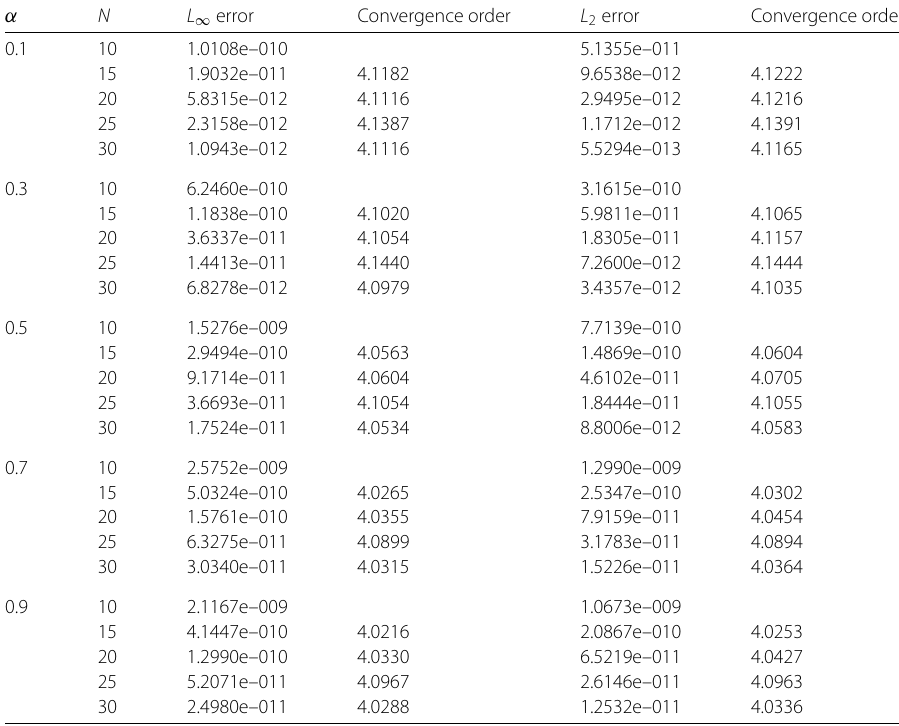
Table 6 The L ∞ , L 2 errors and spatial convergence orders for Example